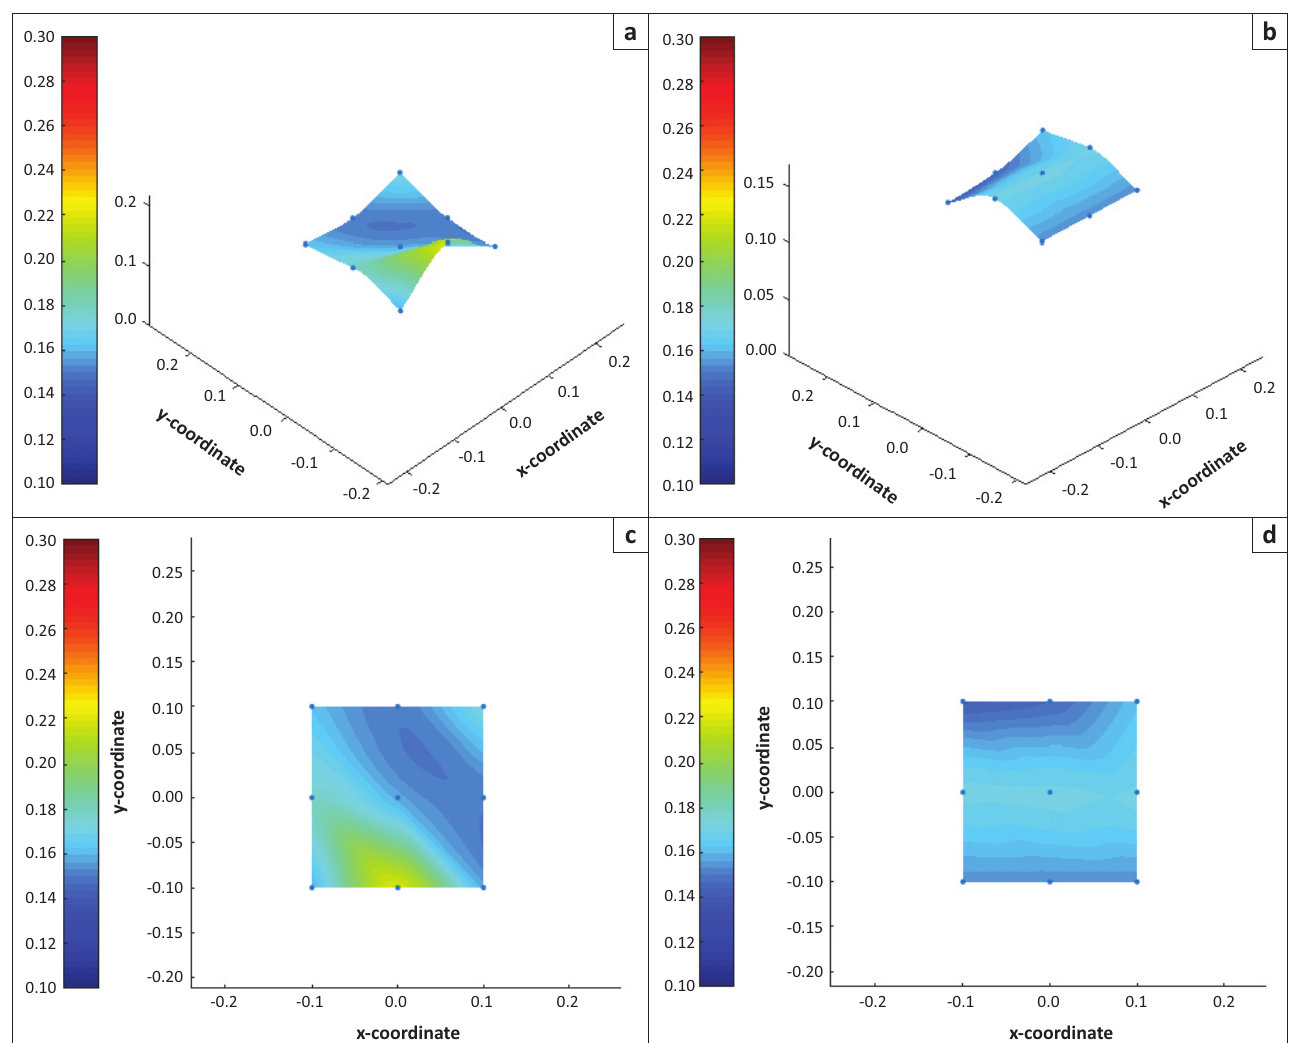
FIGURE 3: Pseudo-3D test (t) and retest (rt) maps for the macular oscillatory threshold field test (MF 9) for Participant 1 (P1). As can be seen, the test and retest maps above illustrate the three-dimensional properties of the map (or surface), while the maps below are indicated in a frontal plane. Units for oscillatory thresholds are micrometres ( µ m) but x - and y -coordinates are in millimetres (mm) on the monitor and not to scale. (a) P1 test, (b) P1 retest, (c) P1 test and (d) P1